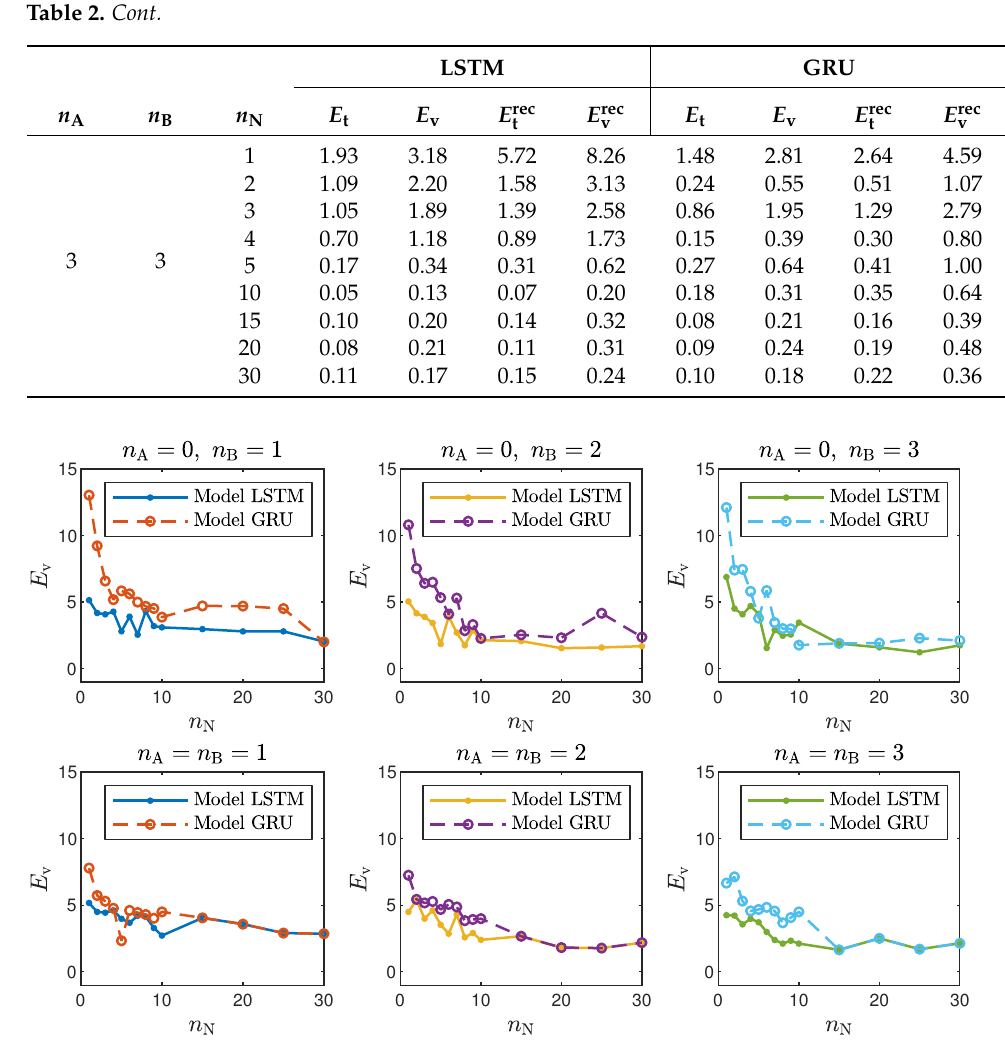
Figure 5. The neutralisation reactor: LSTM and GRU model validation errors for different numbers of neurons n N